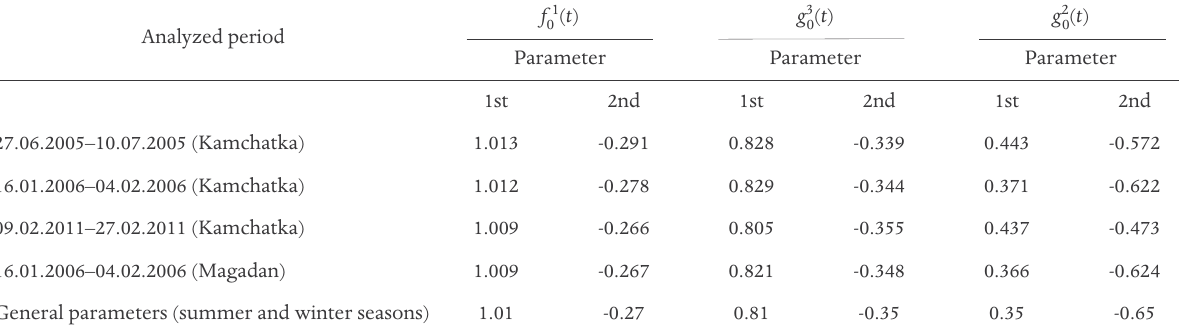
Table 3. Component model parameters.